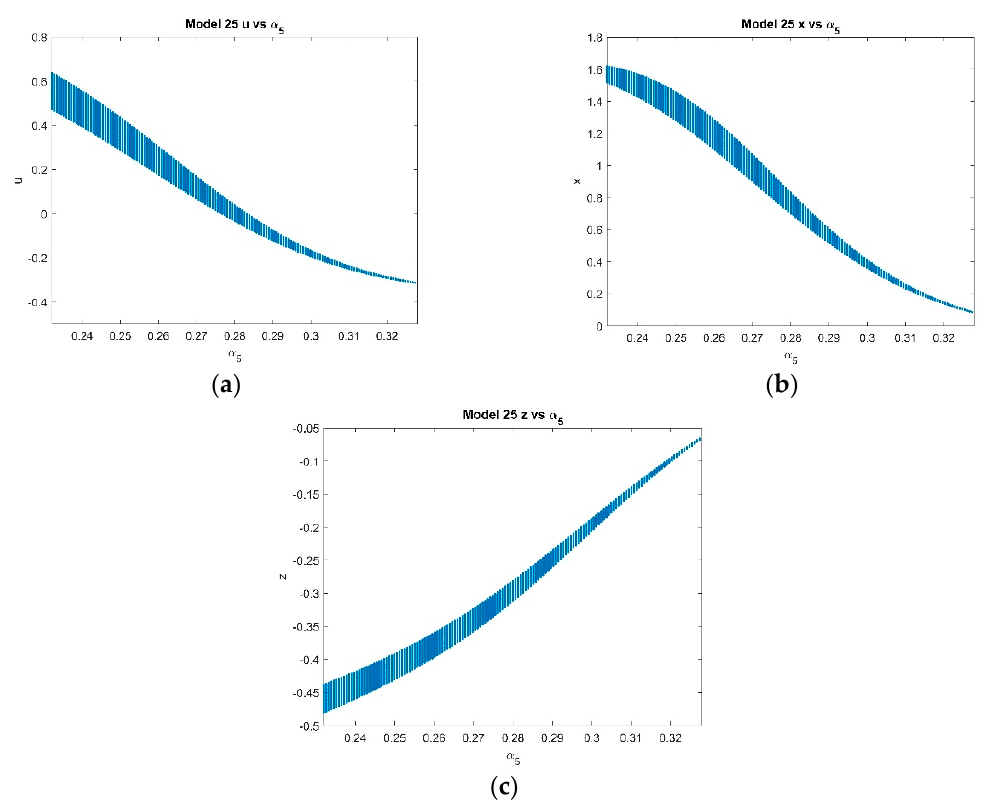
Figure 7. ESDDFD model (24); ( a ) 𝑢 vs 𝛼 (cid:2873) , ( b ) 𝑥 vs 𝛼 (cid:2873) , ( c ) 𝑧 vs 𝛼 (cid:2873) , at 𝑘 = 2, 𝑝 = 1, 𝛼 (cid:2873) ∈ [0.232, 0.328(cid:4671) .